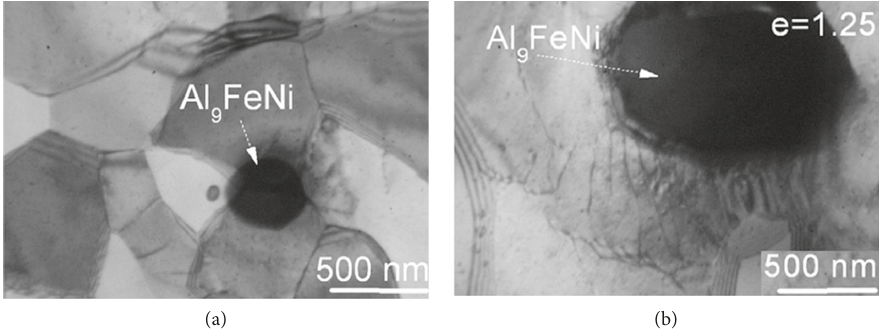
Figure 8: TEM microstructures of Al-Zn-Mg-Sc-Zr alloy: (a) 20 minutes annealed at 480 ° C; (b) strain of 1.25 [87].